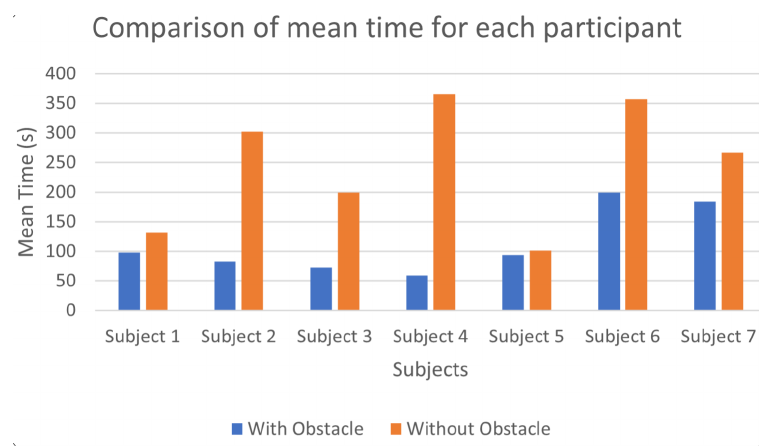
Figure 18. Mean time to touch the target PIM of each participant without (blue) and with an obstacle